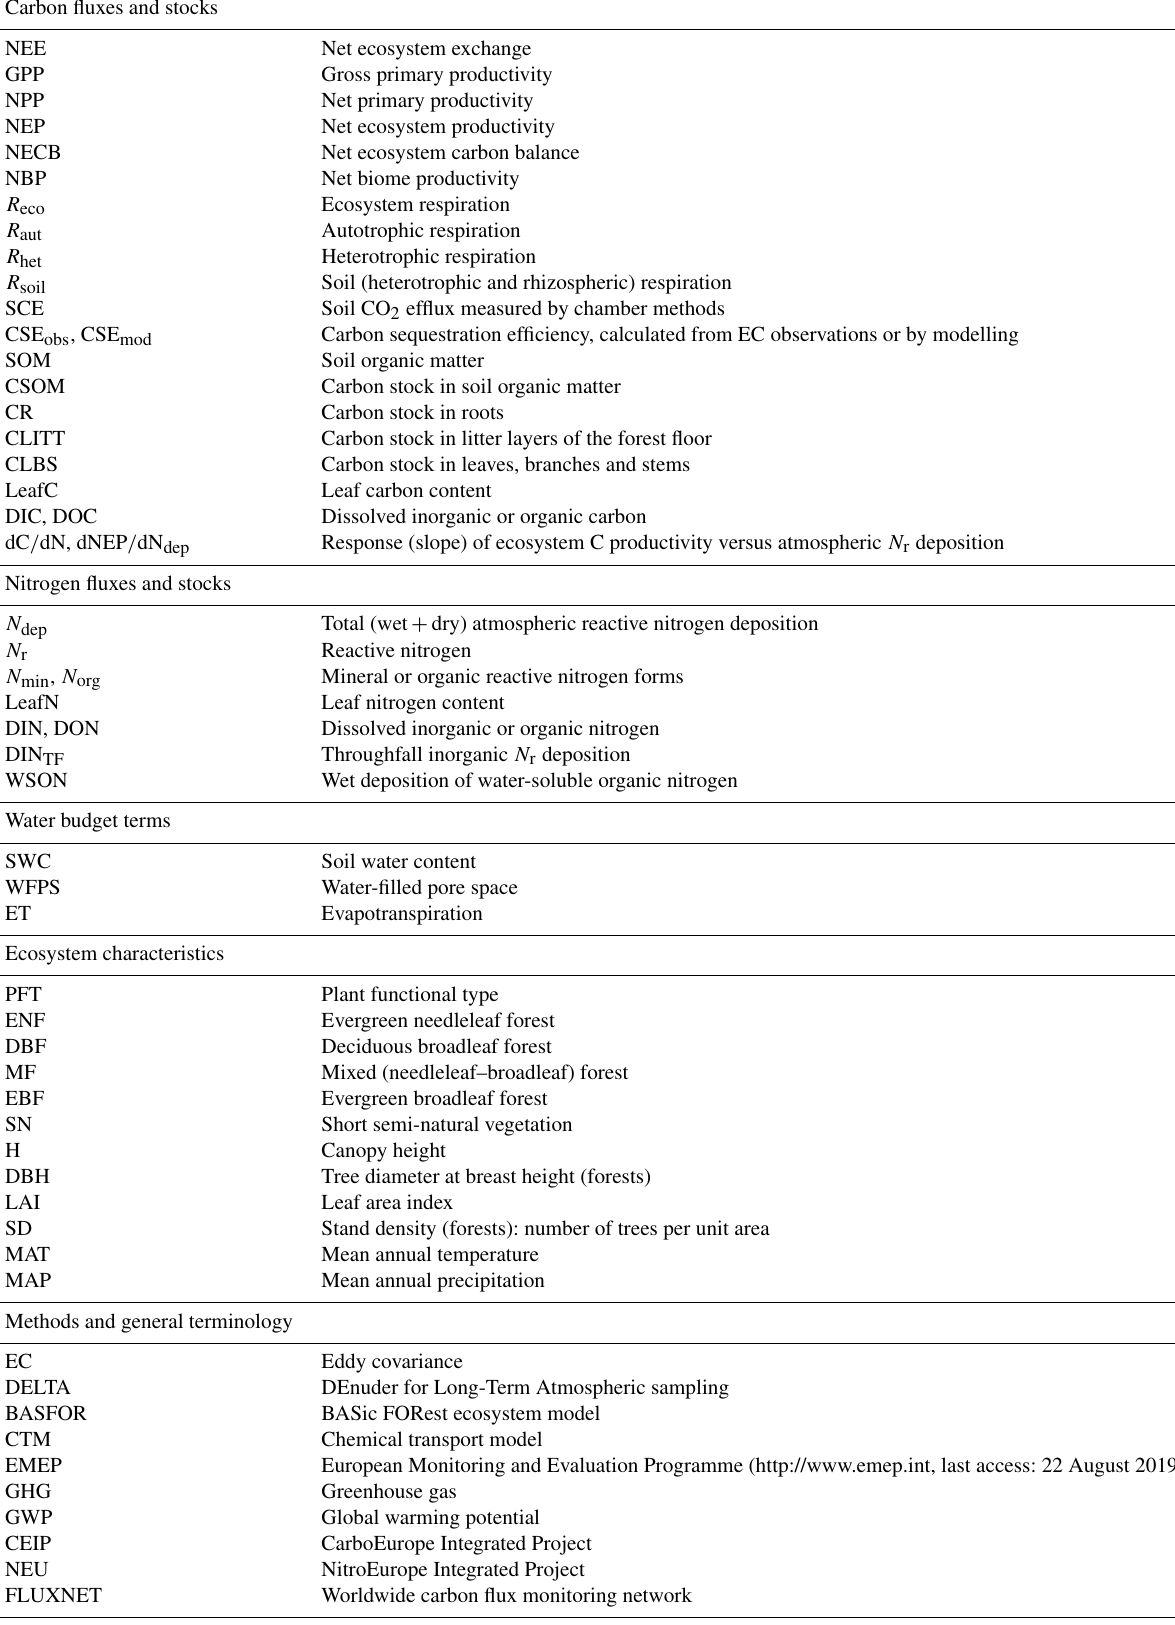
Table 2. Main acronyms and abbreviations used in the study. Carbon fluxes and